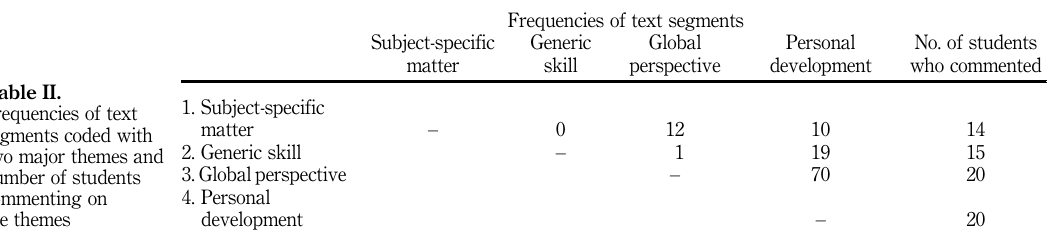
Table II. Frequencies of text segments coded with two major themes and number of students commenting on the